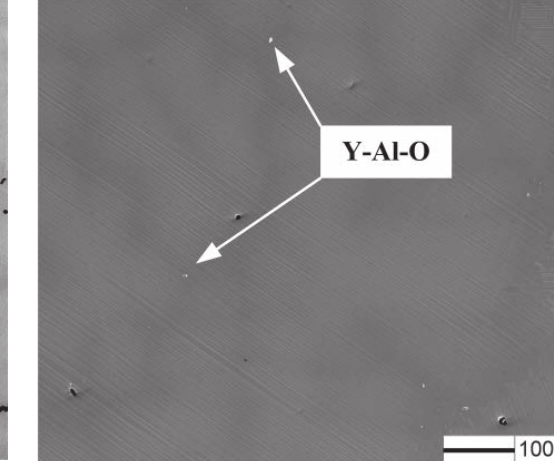
Fig. 9: Inclusions inside the alloy matrix obtained by yttria mould.